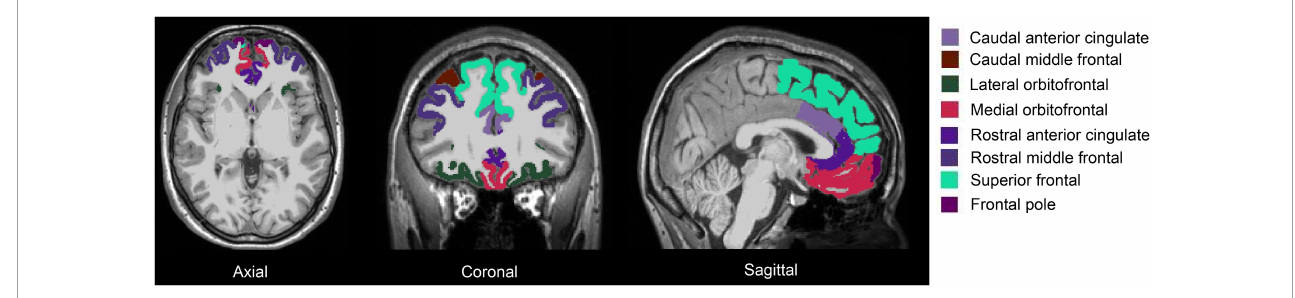
FIGURE2 Segmentation of the prefrontal cortex of one Ice Storm participant. The columns from left to right represent axial, coronal, and sagittal views, respectively. The prefrontal subregions ( left and right ) were labeled with different colors.